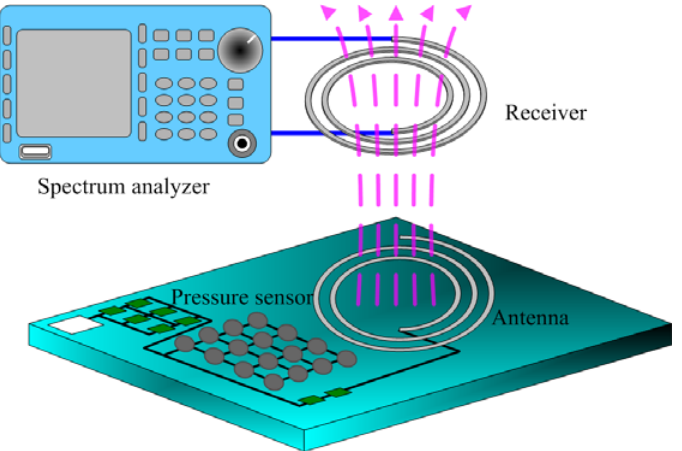
Figure 14. The output signal of the wireless pressure sensor received by a receiver.